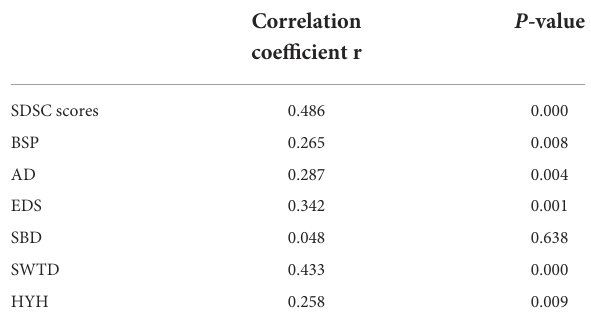
TABLE 4 Pearson correlation analysis between SNAP-IV scores and SDSC scores.